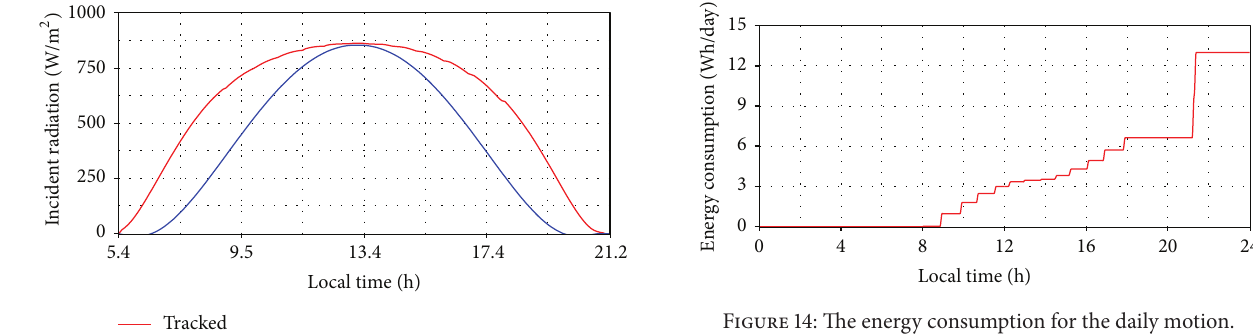
Figure 14: The energy consumption for the daily